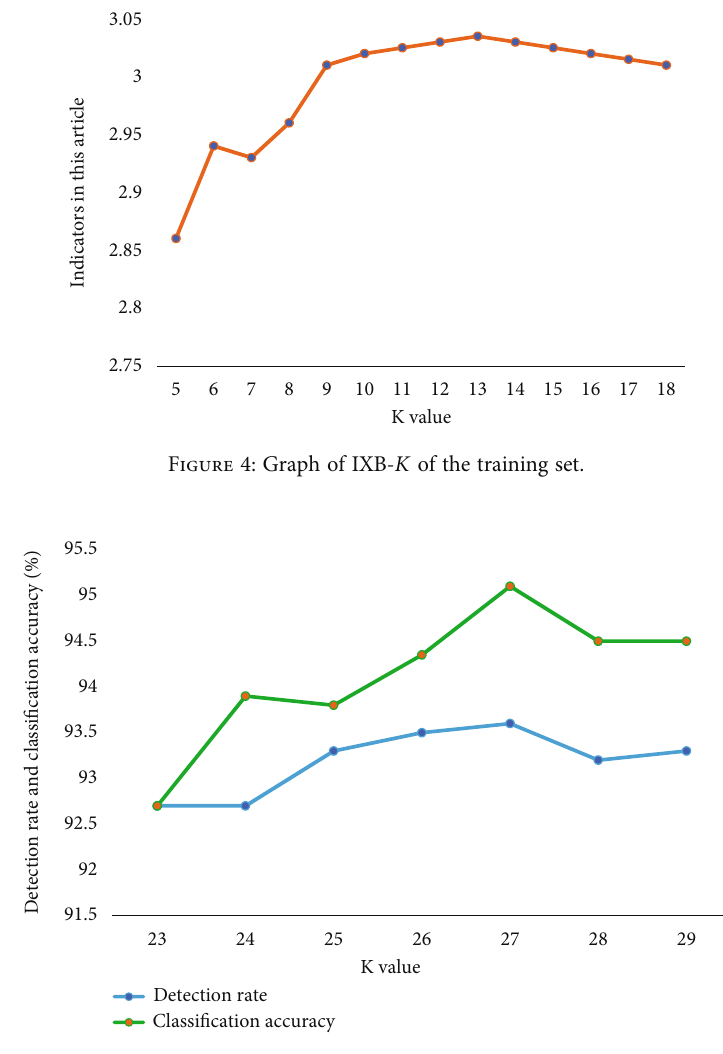
Figure 5: Average detection rate and classi fi cation accuracy for di ff erent K